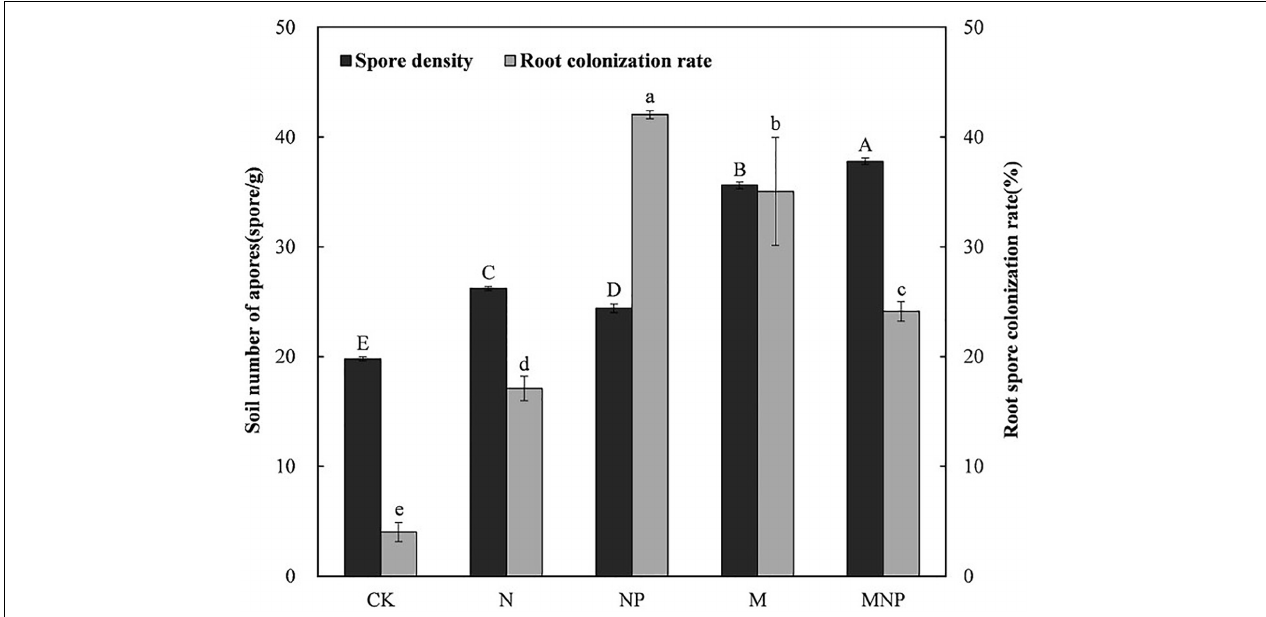
FIGURE 1 | Arbuscular mycorrhizal fungi (AMF) spore density and root colonization rate under different treatments (standard error displayed for n = 3). Columns of the same type designated the same letter are not significantly different ( p < 0.05). CK, no fertilizer; N, mineral nitrogen fertilizer; NP, mineral nitrogen and phosphate fertilizer; M, pig manure; MNP, pig manure, mineral nitrogen, and phosphate